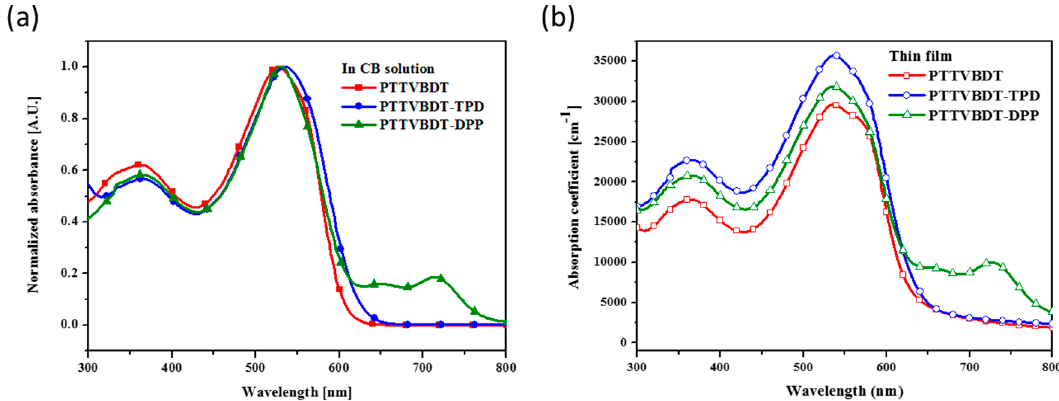
Figure 3. UV–vis absorption spectra of PTTVBDT, PTTVBDT-TPD, and PTTVBDT-DPP ( a ) in dilute chlorobenzene solution; ( b ) thin film (spin-coated from chlorobenzene solution and annealed for 10 min at 130 °C). Table 2. Optical and electrochemical properties of the